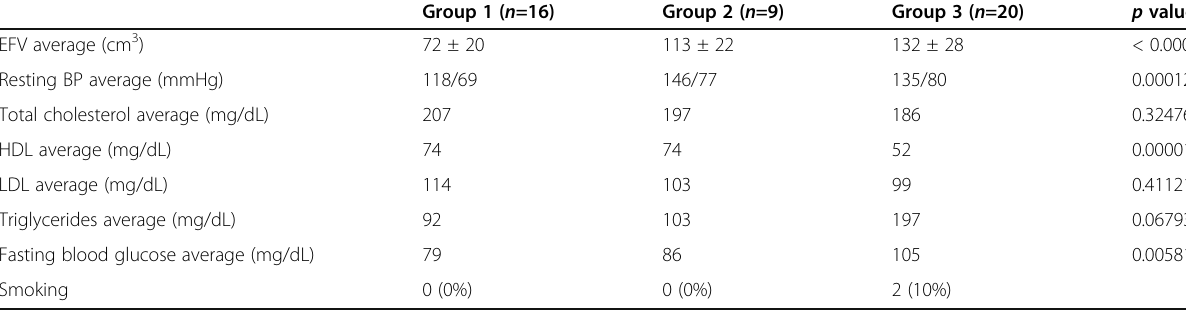
Table 2 Epicardial fat volume and major cardiovascular risk